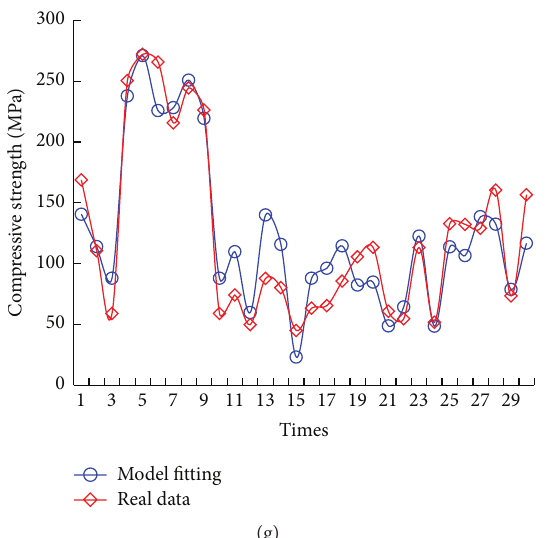
Figure 8: Multitraining results: (a) training on the first group of data; (b) training on the second group of data; (c) training on the third group of data; (d) training on the fourth group of data; (e) training on the fifth group of data; (f) training on the sixth group of data; (g) training on the seventh group of data.